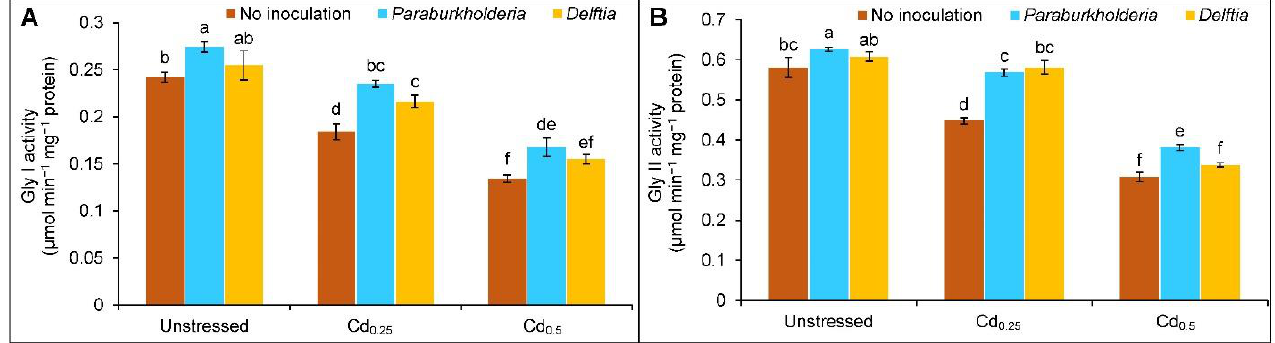
I) and ( B ) glyoxalase II (Gly II) of rapeseed under different levels of CdCl 2 . Here, Cd 0.25 and Cd 0.5 indicated 0.25 and 0.5 mM CdCl 2 , respectively. Different letters on the bars indicate statistical significance at 5% levels of probability following Tukey’s HSD test and the mean (±SD) values obtained from three replications.